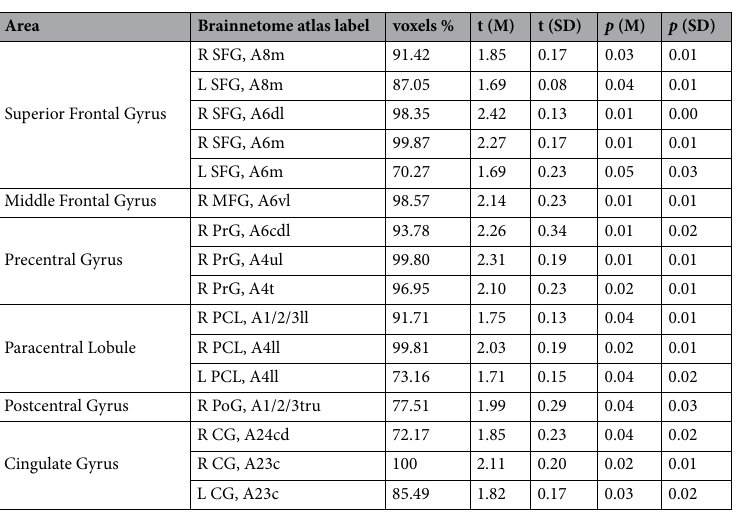
Table 4. Monte Carlo non-parametric permutation statistics on the difference between ROT mov and MOT mov between-blocks ( mov 3– mov 0) post-movement beta power increase. Bonferroni correction was applied to address the multiple comparisons problem. Only significant sources according to the Brainnetome atlas are reported. Voxel % refers to the percentage of significant voxels for the corresponding area; M and SD are respectively the mean and standard deviation of t and p